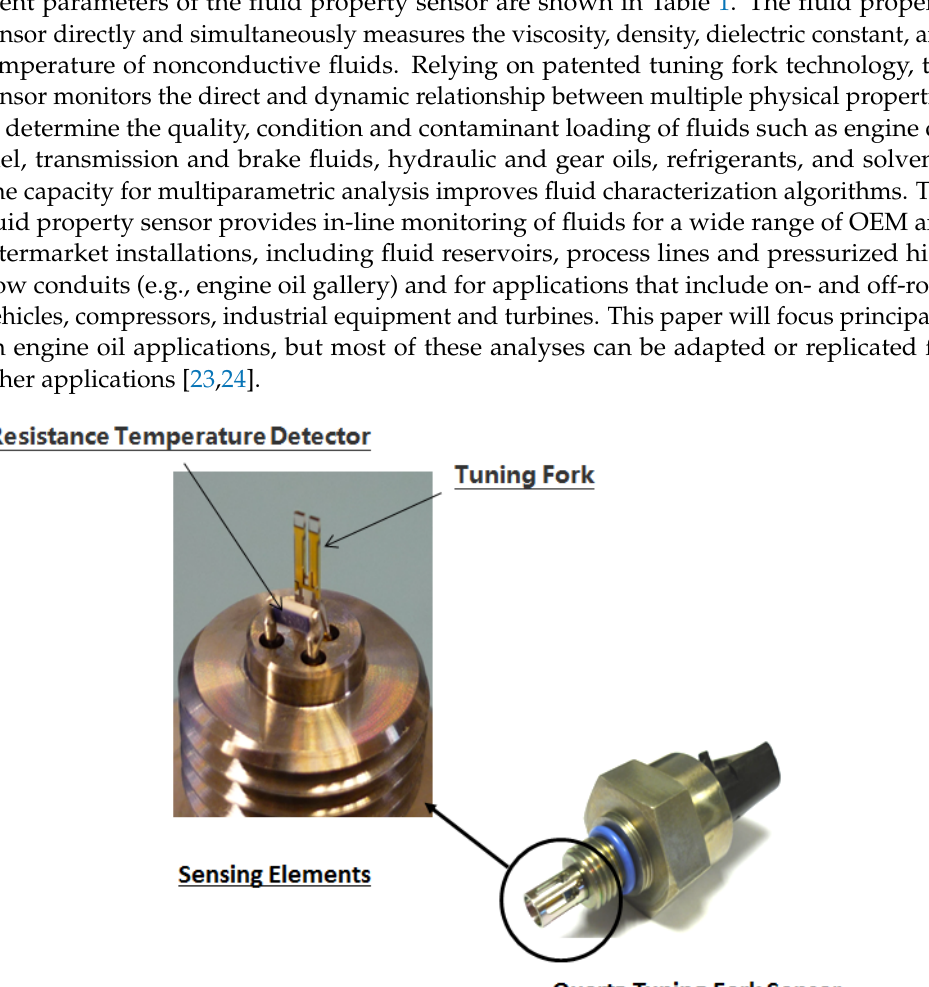
Figure 2. Physical view of quartz tuning fork sensor. Table 1. Measurement parameters of the sensor.